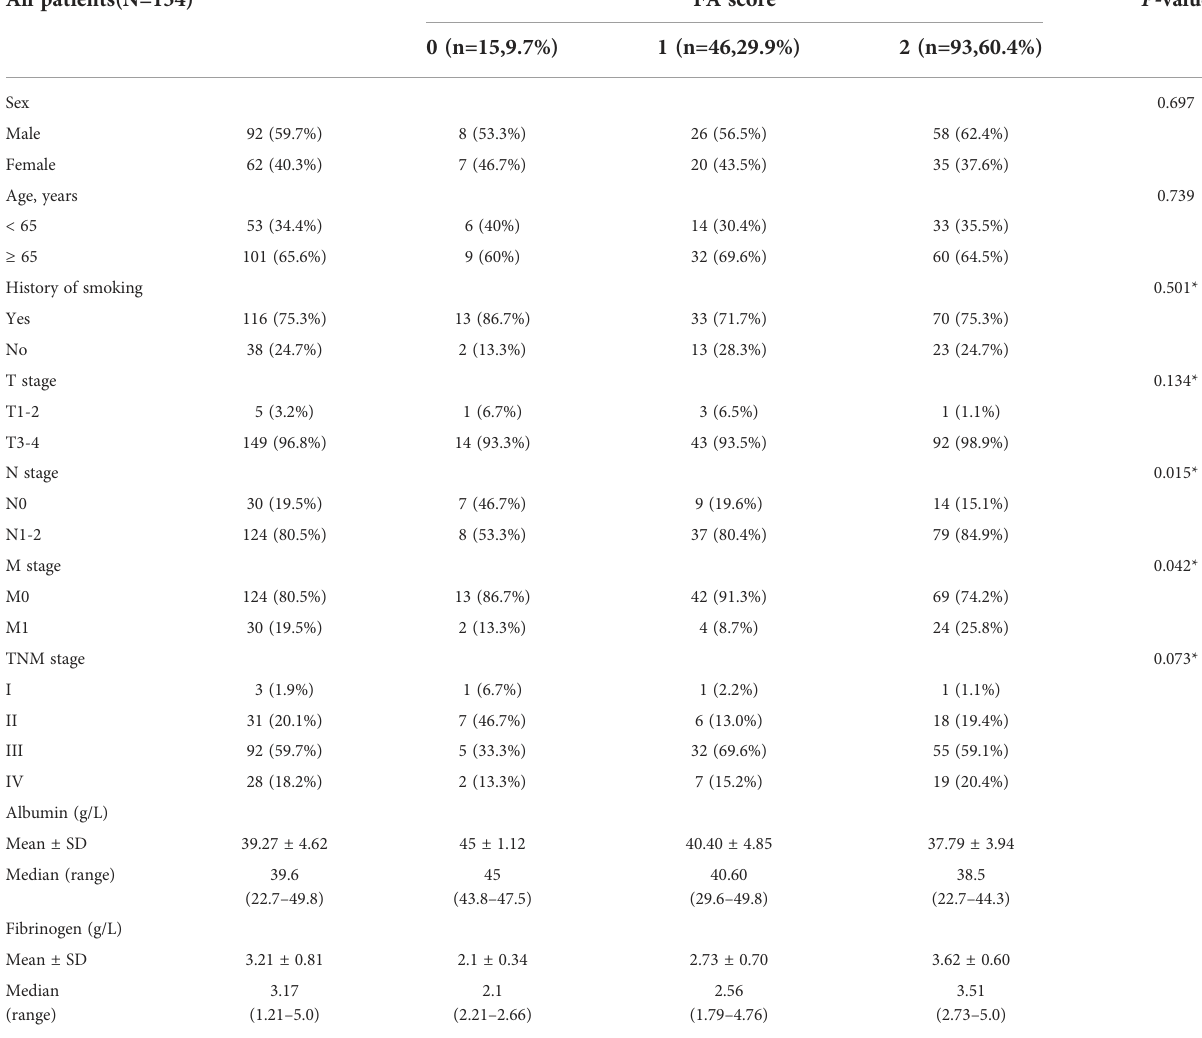
TABLE 1 Baseline clinical characteristics and FA scores of 154 patients with